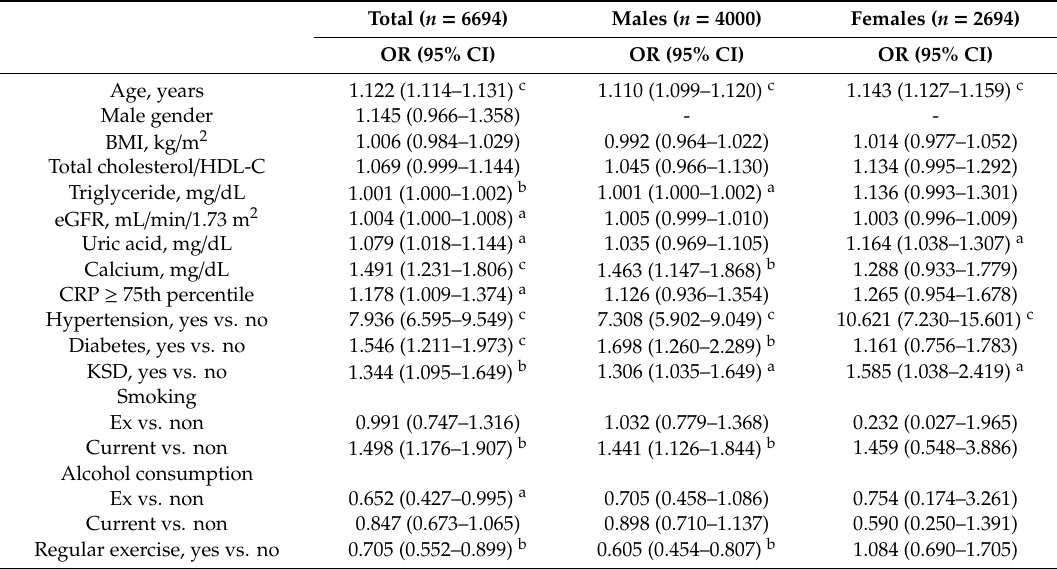
Table 3. Multiple logistic regression analyses for the relationship of KSD and other clinical variables with increased arterial sti ff ness in both genders.